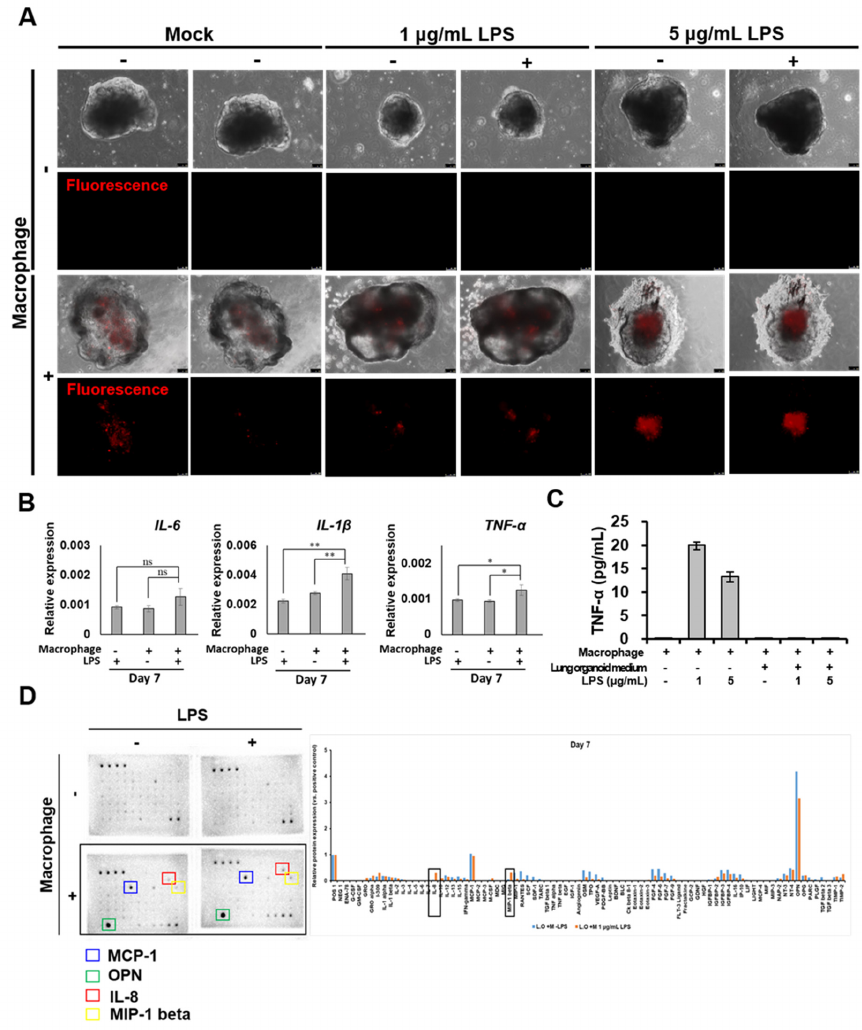
Figure 5. IL-8 and MIP-1 beta were increased in macrophage-included lung organoids under LPS stimulation. ( A ) Representative phase contrast and fluorescent dye images of macrophage-included lung organoid under LPS stimulation. Scale bar = 100 µ m. ( B ) qRT-PCR analysis for IL-6, IL-1 β , and TNF- α expression of lung organoid with or without macrophage and LPS stimulation at day 7 after injection. n = 3. * p < 0.05, ** p < 0.01 versus no treatment group. ( C ) The secretion rate of TNF- α in the hESC-derived iMAC cultured with macrophage cultured medium or, alveolar organoid medium stimulated with LPS. ( D ) Cytokine array images of lung organoid with or without macrophages and LPS stimulation at day 7 after